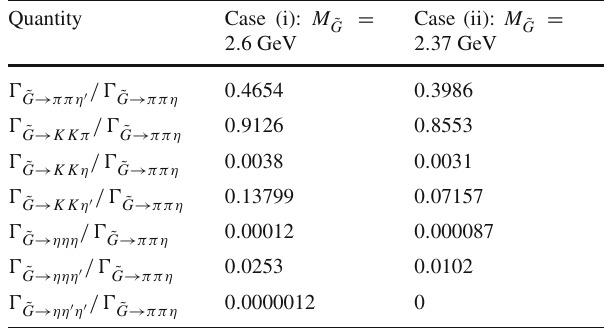
Table 2 Branching ratios for the decay of the pseudoscalar glueball ˜ G into PV and PS Quantity